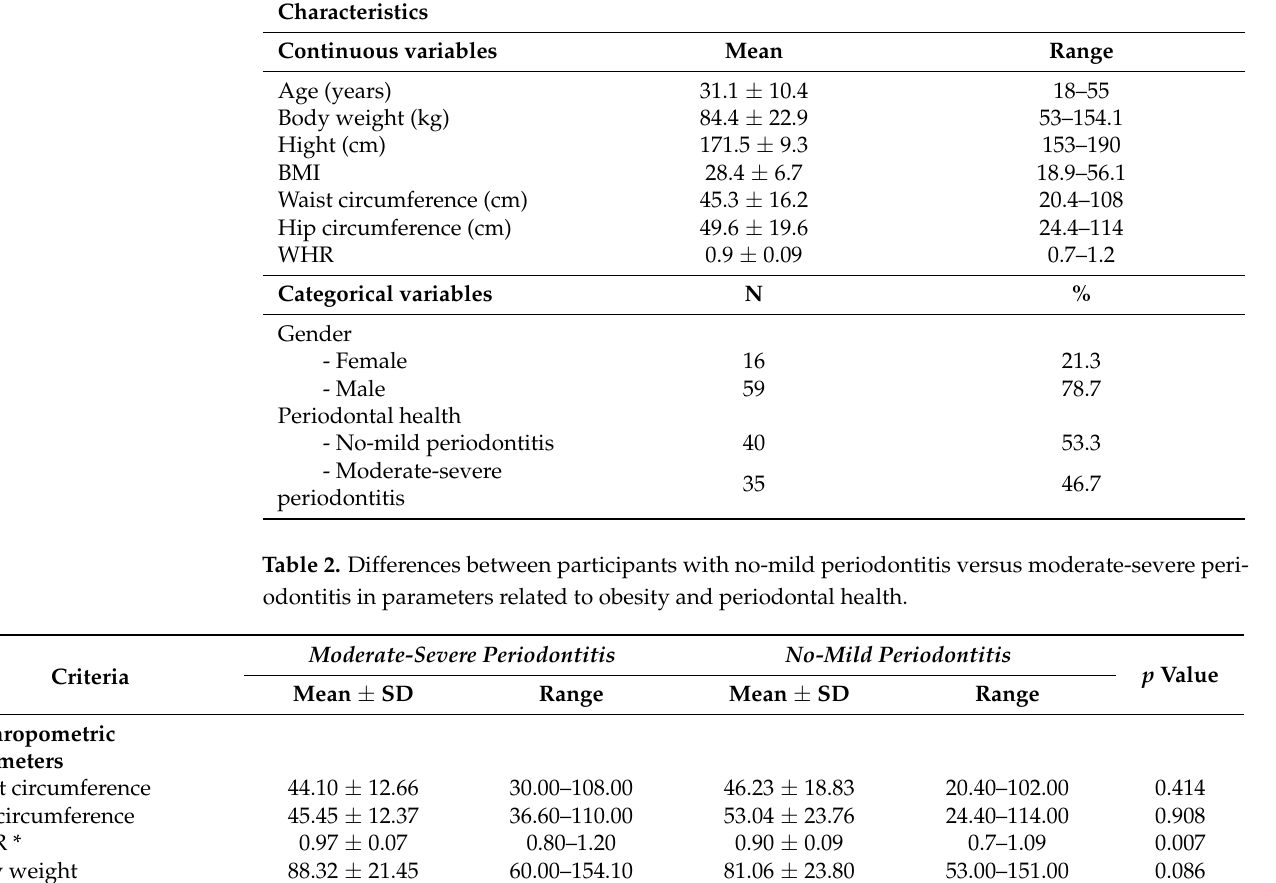
Table 1. Demographic and clinical characteristics of participants.